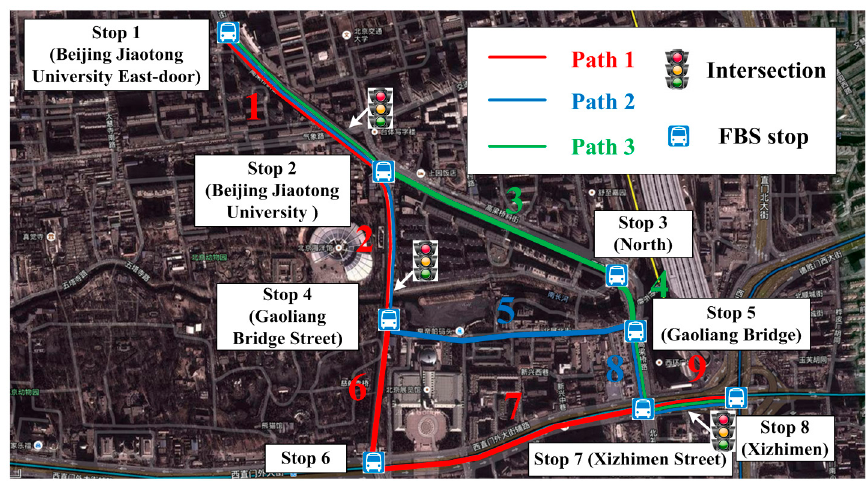
Figure 4. Graphical path for FBS lines and stops (Beijing Xizhimen District). Figure 4 . Graphical path for FBS lines and stops (Beijing Xizhimen District). Figure 4 . Graphical path for FBS lines and stops (Beijing Xizhimen District).